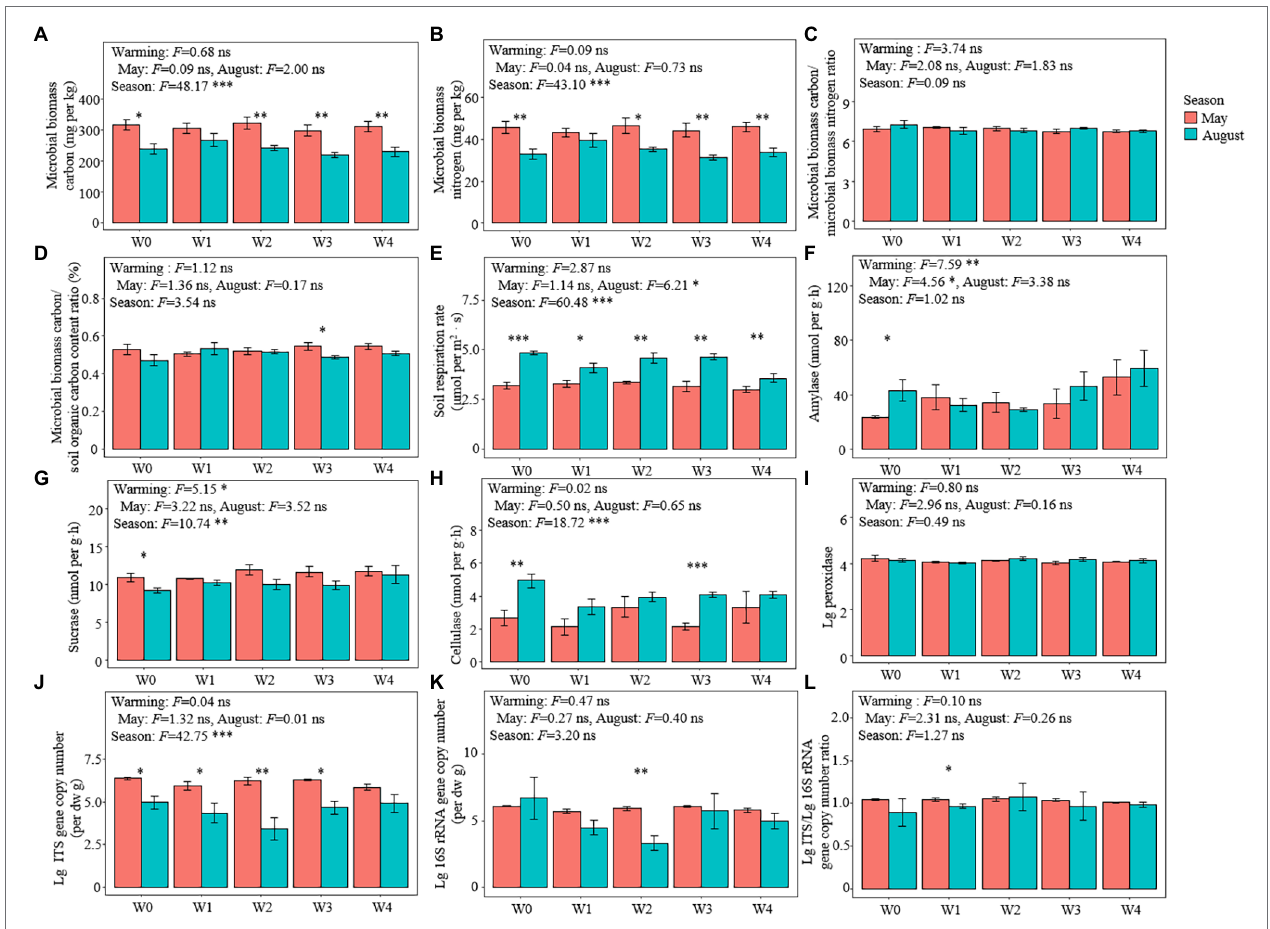
FIGURE 2 | Microbial properties in the different treatments. (A) microbial biomass carbon (MBC) content, (B) microbial biomass nitrogen (MBN) content, (C) MBC/ MBN ratio, (D) MBC/SOC ratio (%), (E) soil respiration rate, (F) amylase activities, (G) sucrase activities, (H) cellulase activities, (I) lg 10 transformed peroxidase activities (lg peroxidase), gene copy numbers of (J) eukaryotic (lg ITS) and (K) bacteria (lg 16S rRNA), and (L) lg ITS/lg 16S rRNA ratio. Bars represent the means ± SE ( n = 5). Significant differences among the treatments were tested using Tukey’s honest significant difference test ( p ≤ 0.05). The F -values and significance shown correspond to the linear mixed-effects model. * p < 0.05, ** p < 0.01, *** p < 0.001. SE, standard